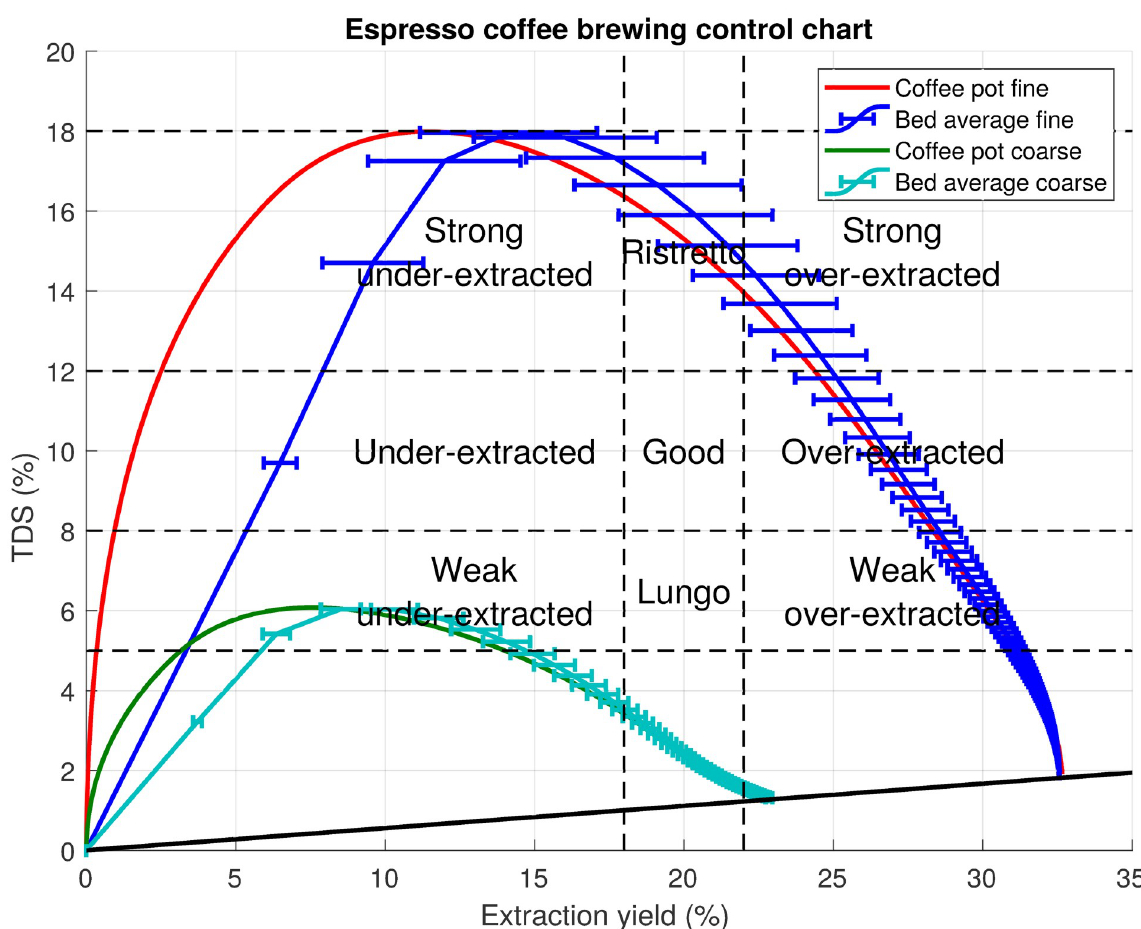
Fig 10. Espresso control chart with extraction uniformity. Coffee brewing control chart for espresso strength preferences. The espresso strength categories are adopted from ref. [10].